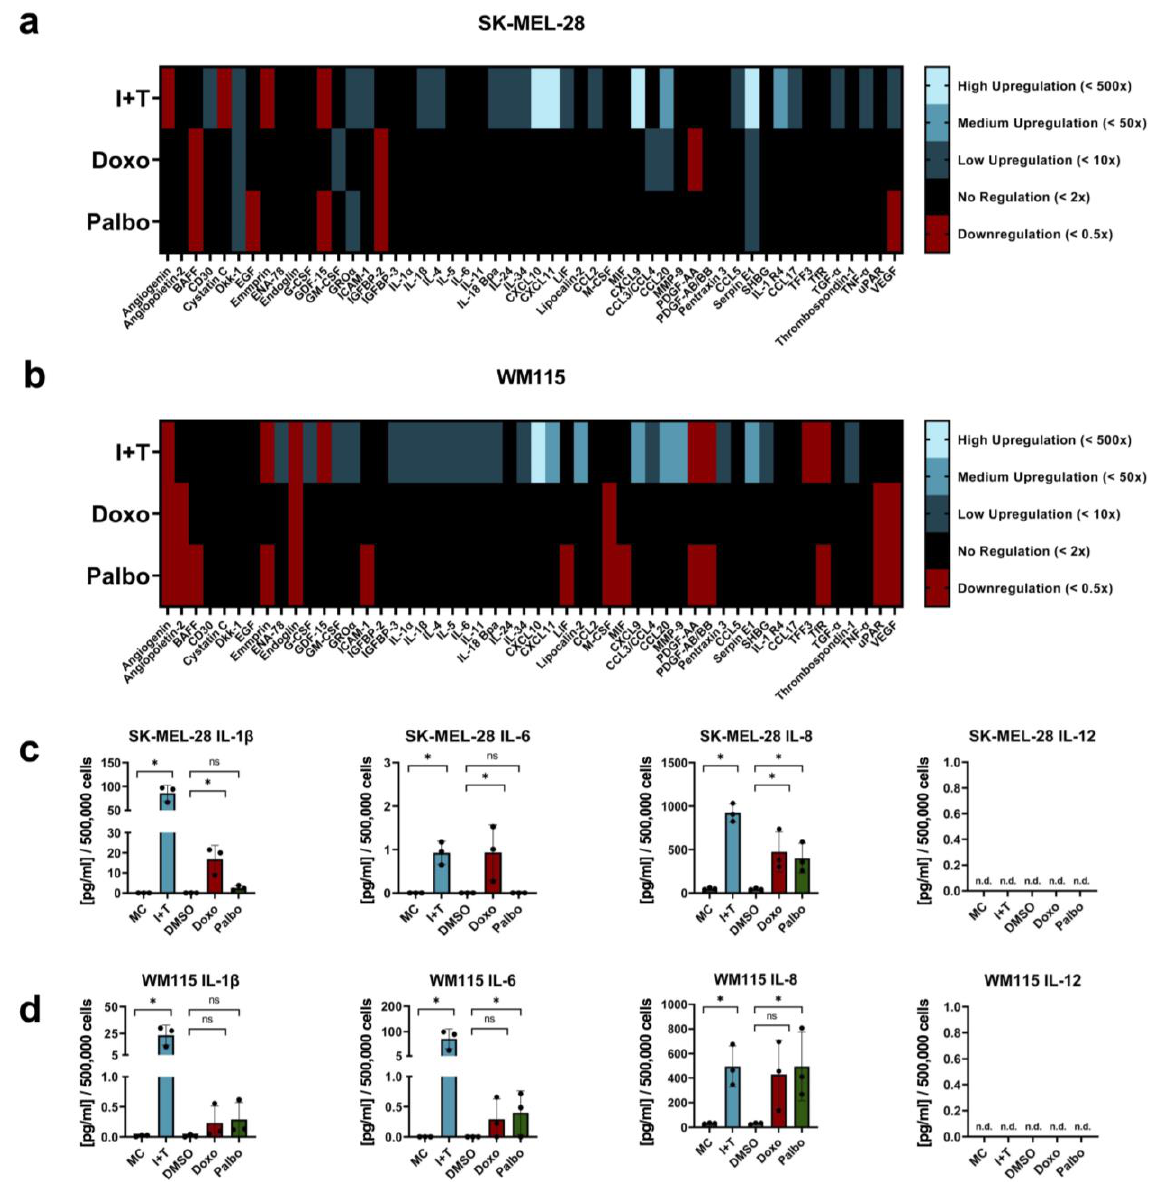
Figure 5. SASP analysis of cytokine- and therapy-induced senescent melanoma cells. ( a , b ) Secretion of cytokines and chemokines by senescent SK-MEL-28 ( a ) and WM115 ( b ) melanoma cells as determined by Proteome Profiler arrays. Supernatants were analyzed 48 h after the end of treatment (i.e., 144 h); the number of cells in each control and treatment whose supernatants were analyzed is indicated in Table A2. Densitometric measurements of proteins in the supernatants derived from cytokine-, doxorubicin-, and palbociclib-treated cells were normalized to the medium control. ( c,d ) Quantification of IL- 1β, IL -6, IL-8, and IL-12 levels in the supernatants of senescent SK-MEL-28 ( c ) and WM115 ( d ) melanoma cells as measured by ELISA and normalized to 500,000 cells. Supernatants were analyzed 48 h after the end of treatment. ( a , b ) Results are from three independent experiments ( n = 3) and show the mean intensity value. ( c , d ) Results are from three independent experiments ( n = 3); n.d., not detectable; ns, not significant; one-way ANOVA; mean ± s.d.; an asterisk (*) indicates a significant difference from the respective controls with p < 0.05.